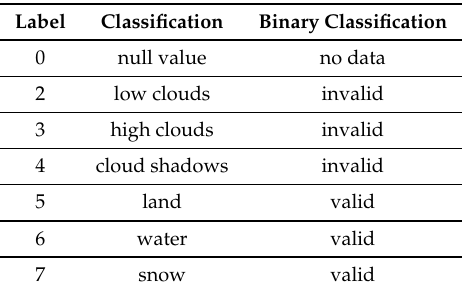
Table 6. Conversion from ALCD classes to valid/invalid.